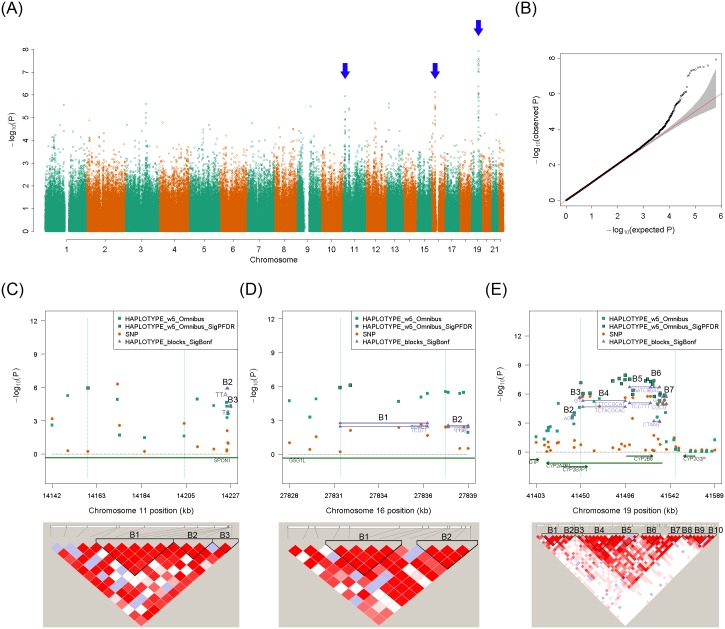
Sliding-window genome-wide haplotype analysis of plasma concentration of S-methadone.(A) Manhattan plot of genome-wide haplotype-based association test. The vertical axis is the raw p values of the omnibus haplotype tests (in a scale of -log10) and the horizontal axis is physical position of the initial SNP of a haplotype in different autosomes. Each point indicates the raw p value of a window. The positions of significant haplotypes are indicated by blue arrows. (B) Quantile–Quantile plot of genome-wide haplotype-based association test. The vertical axis indicates the raw p values of the association tests (in a scale of -log10). The horizontal axis indicates the expected p values of the association tests (in a scale of -log10) under a null hypothesis, i.e., no genetic association. (C) Regional association plot and LD plot on chromosome 11. In the regional association plot, the vertical axis is the raw p values of the association tests (in a scale of -log10) and the horizontal axis is physical position of initial SNP of a haplotype (in unit of kb). Raw p values of single SNPs (orange circle) and haplotypes which were significant after adjusting for false discovery rate [26] (symbol: green square with frame) and were not significant (symbol: green square without frame) are shown. Moreover, haplotypes which passed a multiple-test correction of a false discovery rate [26] in a LD block (purple triangle) are shown. In the LD plot, pairwise LD of SNPs was measured by D’ [27]. SNPs with a strong LD were framed in a black inverse diamond block which was defined according to the confidence interval method [24]. (D) Regional association plot and LD plot on chromosome 16. (E) Regional association plot and LD plot on chromosome 19.